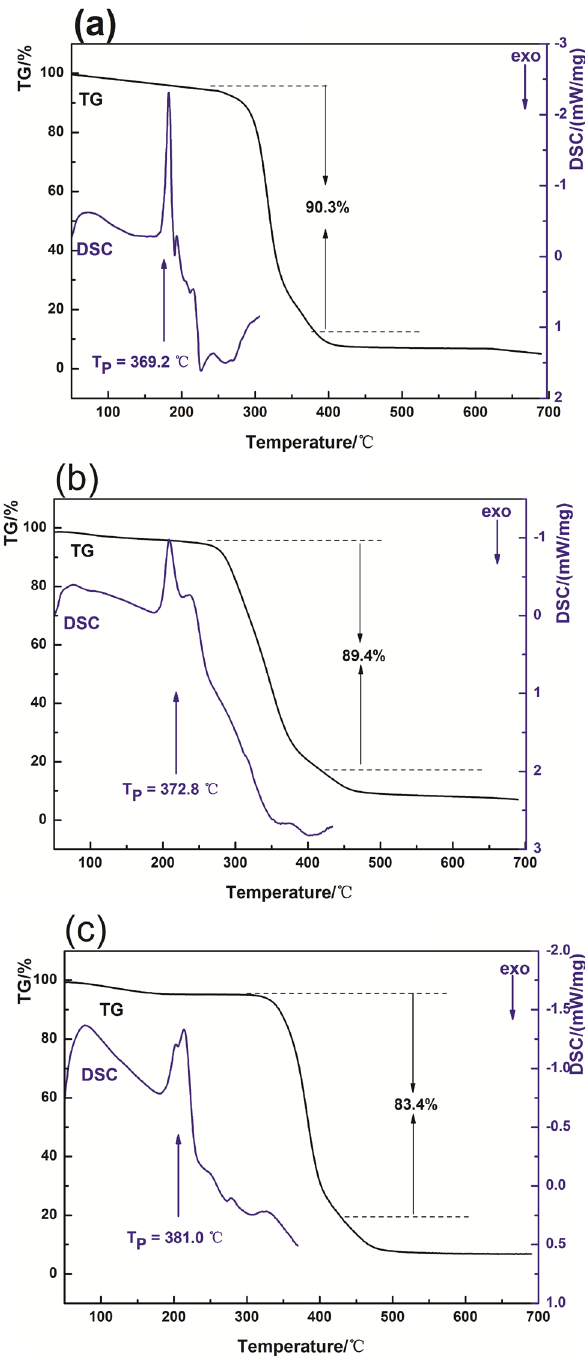
Figure 5: TGA and DSC thermograms of the fi lms: ( a ) neat PVB, ( b ) LaB 6 - PVB, and ( c ) LaB 6 @TiO 2 - PVB.